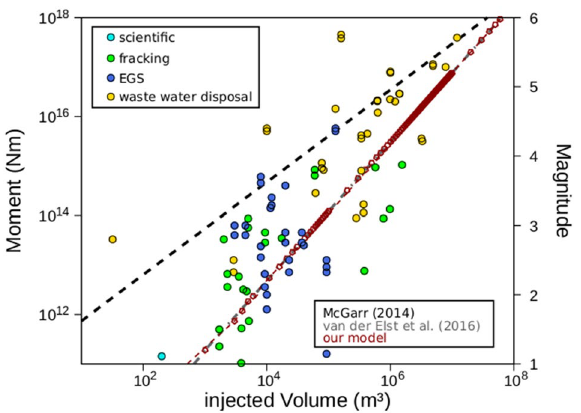
Figure 1. Maximum observed magnitudes and seismic moment as a function of the total injected volume for a number of site applications. Data were taken from 9,29–31 . The predictions from this study (Eq. 7 in the main text) are shown by the red squares. The black curve is estimated by 9 (G = 30GPa) and the grey curve by 10 using the same seismogenic index ( (cid:31) 0 = − 1.8 ) and a constant b value (b = 1) as in our